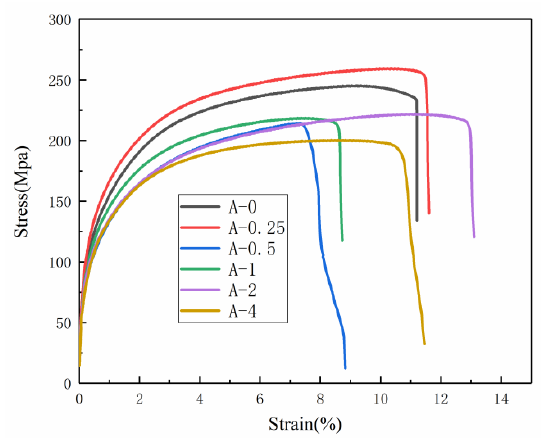
Figure 6. Tensile stress – strain curve of the annealed Al-14.5Si alloys solidified under a super-gravity field.